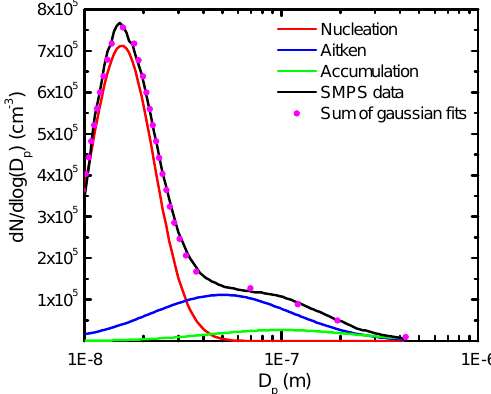
Fig. 7. Average aerosol size distribution in the JQ tunnel. Particle size distribution was measured from 2 to 6 May 2011. The average particle number concentration was 73000cm − 3 with an average di- ameter of 48.4nm.